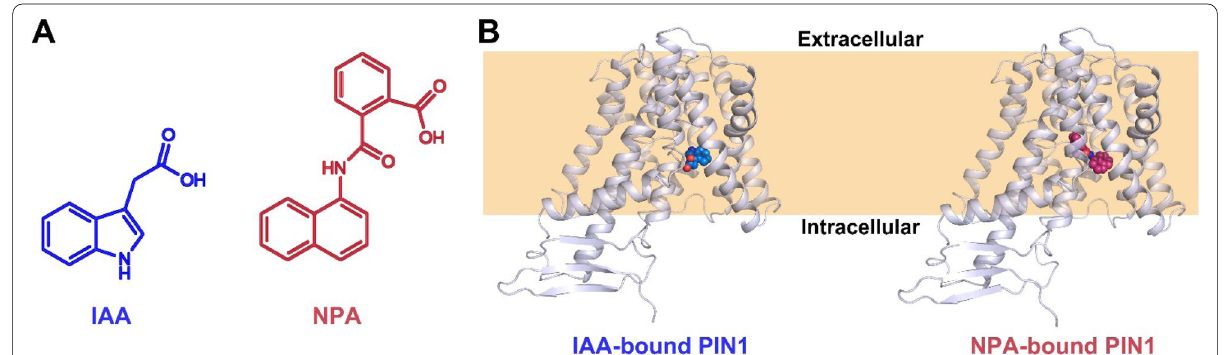
Fig. 1 Structures of auxin- and NPA-bound PIN1 protein. A Chemical structures of the natural auxin IAA and the synthetic inhibitor NPA. B Structures of IAA- and NPA-bound PIN1 protein. Left, IAA-bound PIN1 structure (PDB accession code: 7Y9V). Right, NPA-bound PIN1 structure (PDB accession code: 7Y9U, Yang et al. 2022). PIN1 protein is shown in a cartoon mode and colored light blue. IAA and NPA molecules are shown in spheres, with carbon atoms colored blue and red,